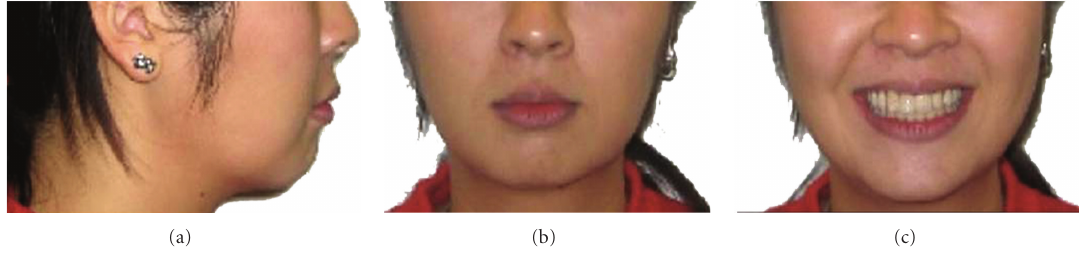
Figure 12: Posttreatment extraoral